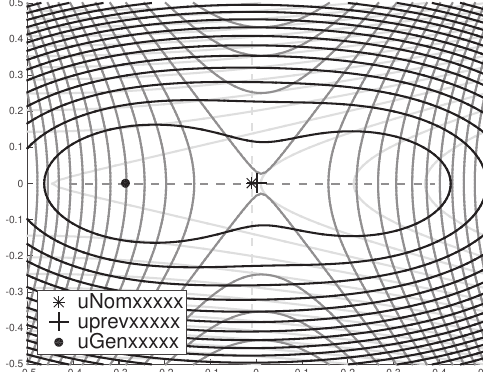
Figure 6. Example of problem where the quadratic approximation (58) is unbounded, while (53) has a solution. The black lines report the level curves of the cost of Problem (67); the grey lines report the level curves of the cost of Problem (68); and the light grey lines report the level curves of the cost of Problem (69) where Q = delivering a full-rank approximation of Σ 2 (see the light-grey dashed line) that point to the direction of the solution to (67); hence, ignoring ∇ 2 φ 0 is problematic